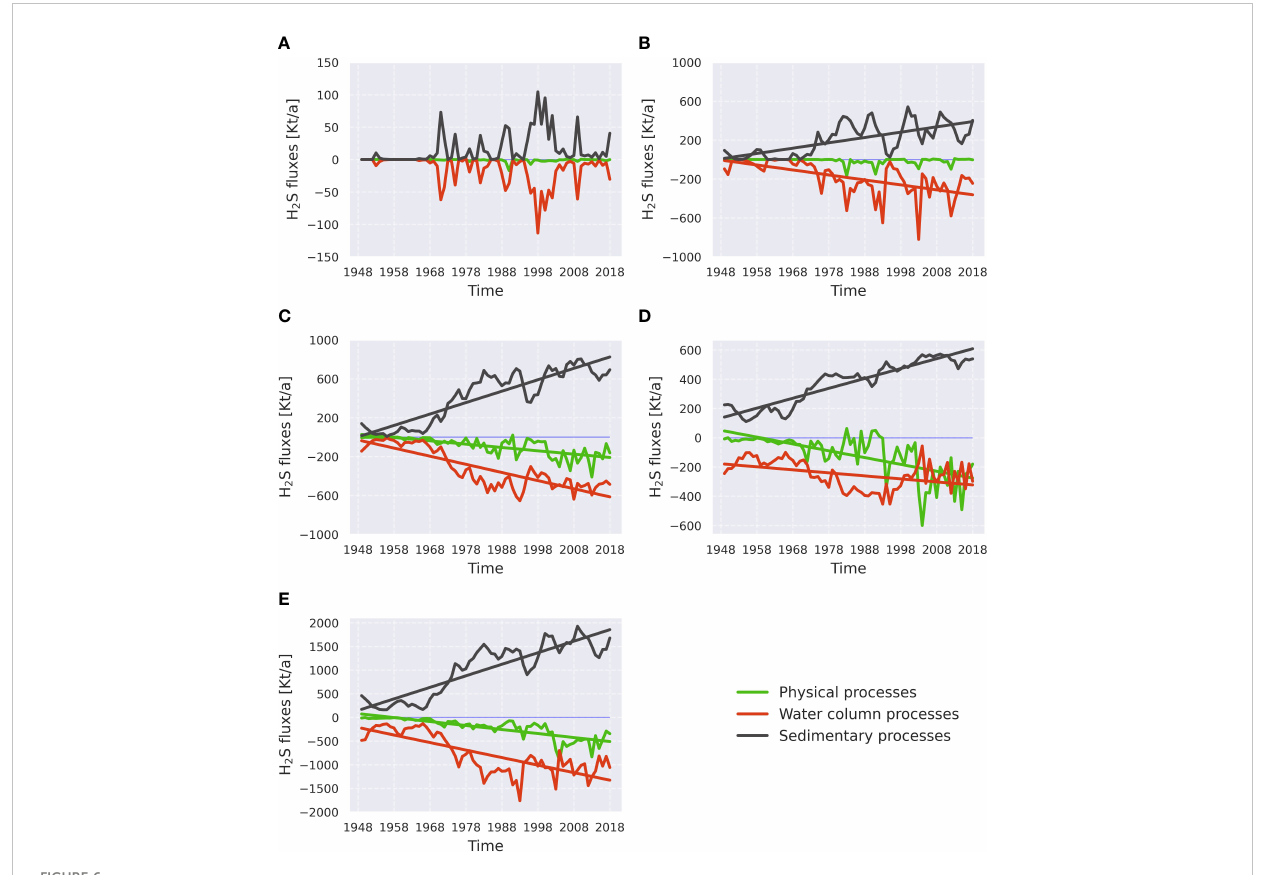
FIGURE 6 As Figure 5 but for hydrogen sul fi de. The order of subplots is the same as in Figure 5: (A) - the Bornholm Basin, (B) - the eastern Gotland Basin, (C) - the northern Gotland Basin, (D) - the western Gotland Basin, and (E) - the whole central Baltic Sea. Kt/a stands for 10 6 kg per year. See Supplementary Table 2 for more information about processes in each